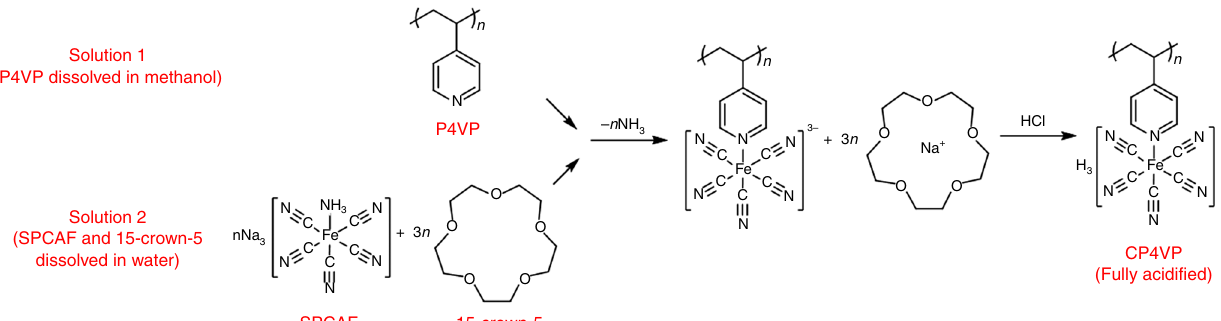
Fig. 1 Synthesis of coordinated polymer. CP4VP is synthesized from P4VP and SPCAF. The pyridyl group in P4VP replaces the – NH 3 ligand of Fe and becomes a substitutive ligand to obtain the coordinated polymer. CP4VP: ferrocyanide-coordinated poly(4-vinylpyridine); P4VP: poly(4-vinylpyridine); SPCAF: sodium pentacyanoammineferroate (II); 15-crown-5: 1,4,7,10,13-pentaoxacyclopentadecane